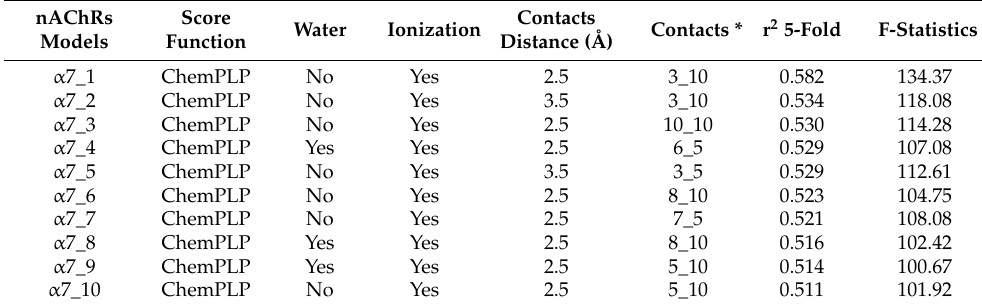
Table 3. Docking conditions and statistics for the 10 best dbCICA models for α 7 receptor.